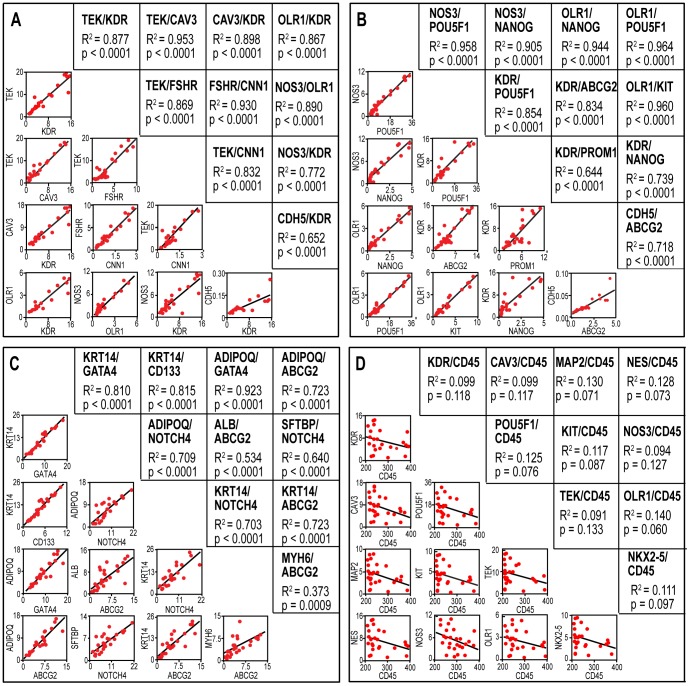
Regression analysis of genes co-expressed in PBMCs isolated from healthy human adults.
A. Correlations between several cardiovascular-specific genes. B. Correlations between selected vascular and primitive genes in the same population. C. Correlations between other tissue-specific and primitive genes. D. Inverse correlation between the expression of vascular genes and a leukocyte gene (PTPRC/CD45). In all the graphs, the number of subjects is n = 26, R2 is the linear regression coefficient, and p indicates significance; these coefficients were placed in mirror positions across the diagonal with their corresponding graphs. The data represent RCNs.